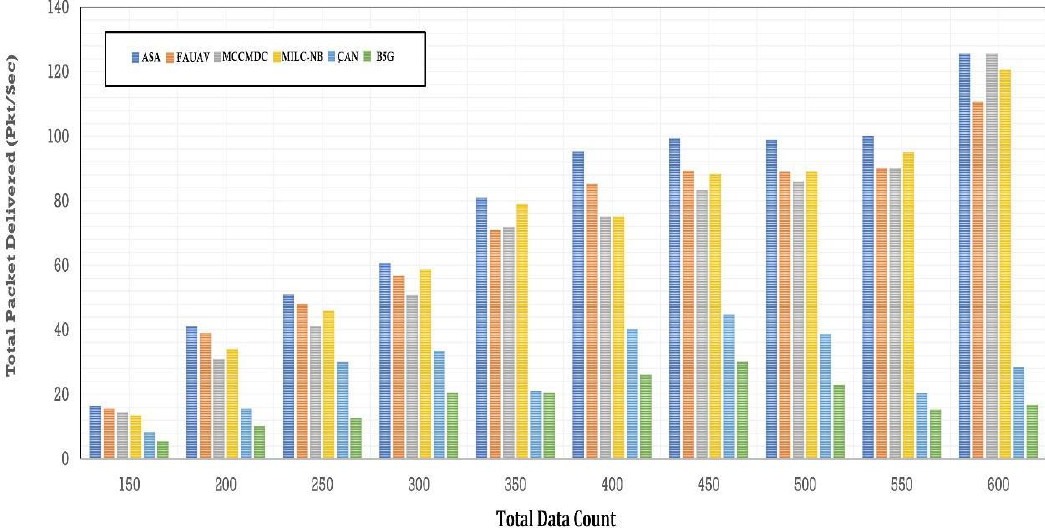
Figure 5. Packet delivery ratios before data